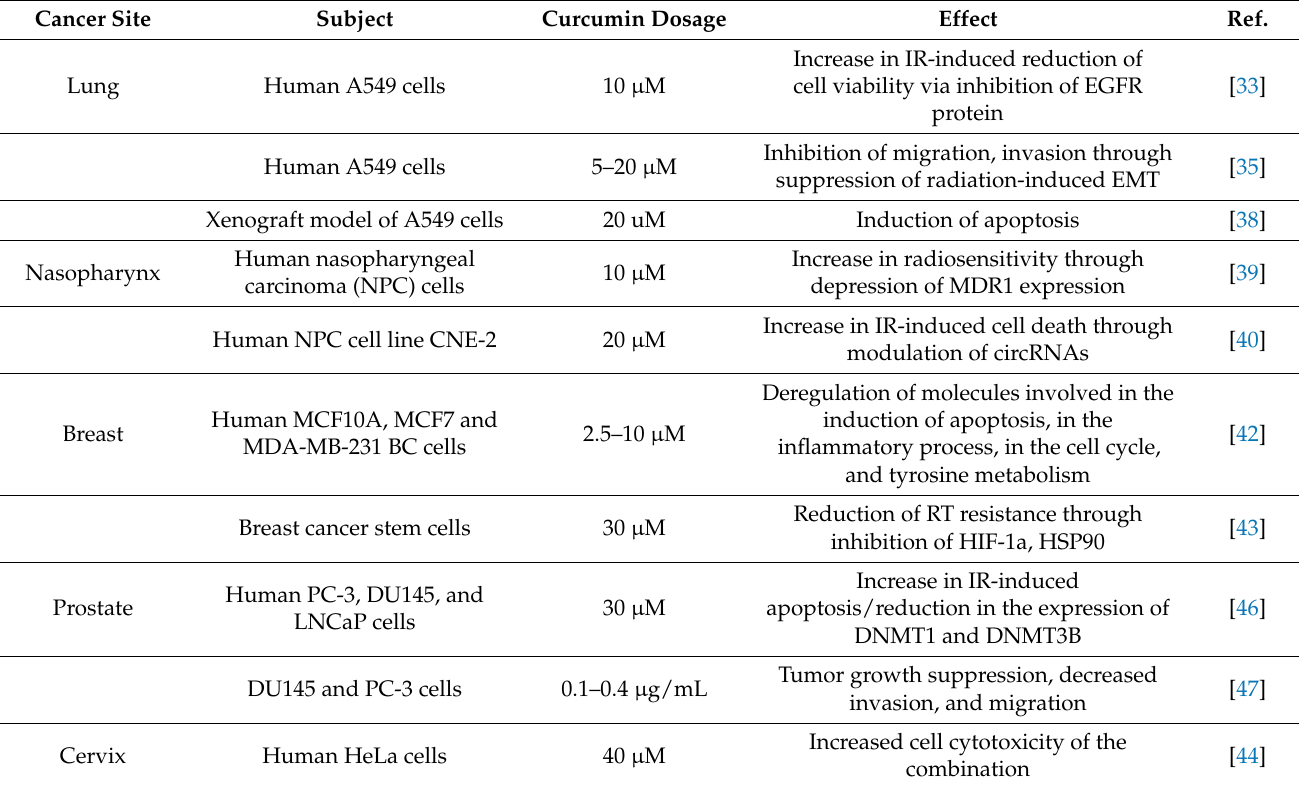
Table 1. Radiosensitizing effects of curcumin on different cancer